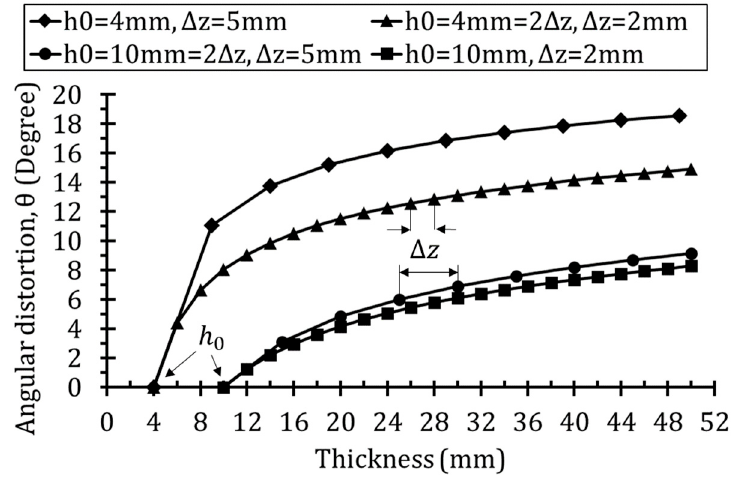
Figure 16. Prediction of angular distortion at different bead heights and initial thicknesses.